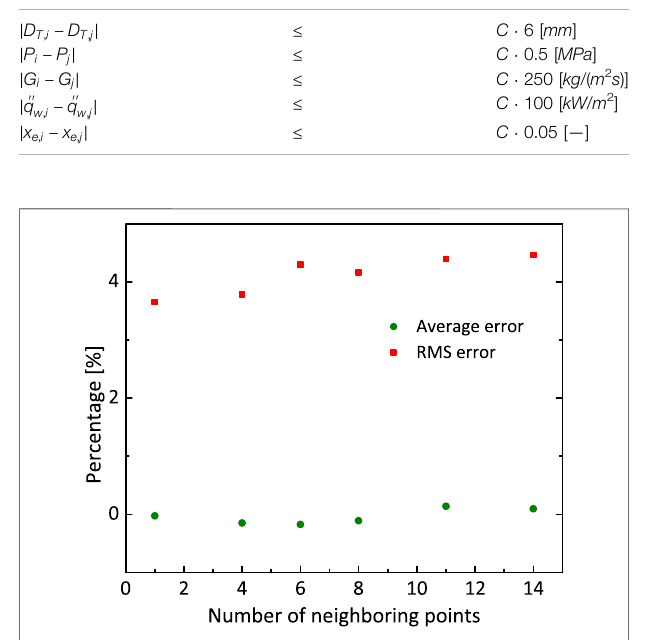
FIGURE 3 | Assessment results versus the number of neighboring points n .